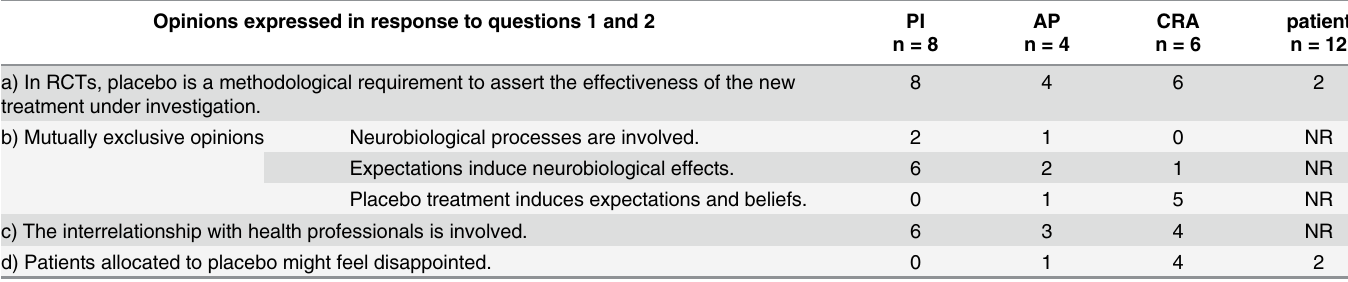
Table 3. Conceptualization of the placebo response. Opinions expressed in response to questions 1 and